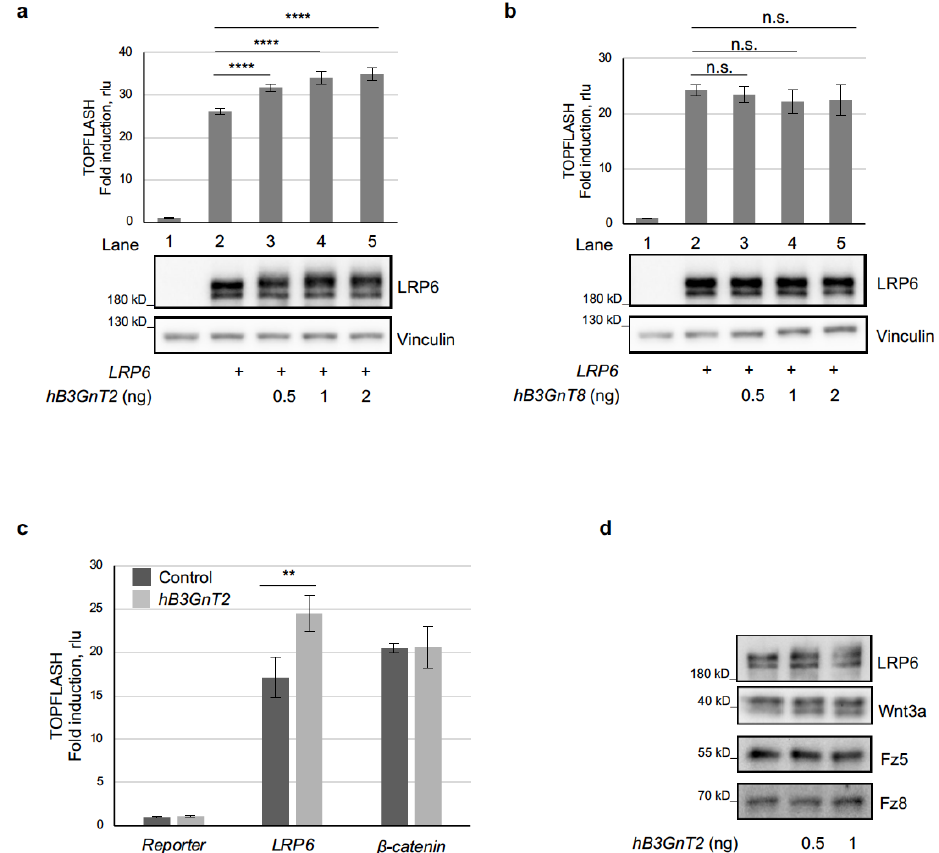
Figure 2. Human B3GnT2 promotes Wnt/β -catenin signalling and acts at the level of LRP6. ( a , b ) TOPFLASH Wnt reporter assays (upper graphs) and Western blots (lower blots) showing that human B3GnT2, but not B3GnT8, modifies LRP6 and promotes Wnt/β -catenin signalling in a dose-dependent manner. Amounts transfected: LRP6 , 20 ng; hB3GnT2 or hB3GnT8 , as indicated. Data represent mean + SD. **** p < 0.0001. n.s., not significant. ( c ) TOPFLASH reporter assay in HEK293T cells in 96-well format. Amounts transfected: LRP6 , 20 ng; β -catenin , 50 ng; hB3GnT2 , 0.5 ng. Data represent mean + SD. ** p < 0.01 ( d ) Western blots of cell lysates from HEK293T cells in 96-well format. Amounts transfected: hLRP6 , 20 ng; mWnt3a , 8 ng; V5-mFz5 or V5-mFz8 , 20 ng; hB3GnT2 , as indicated.